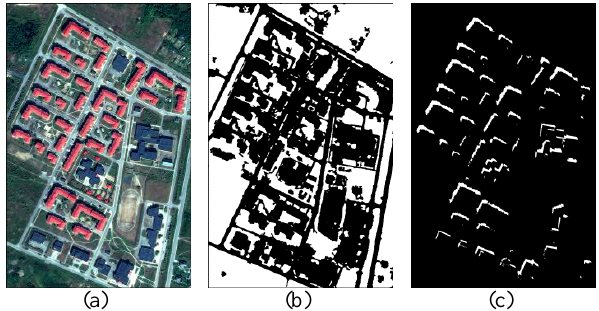
Figure 1. (a) GeoEye-1 pan-sharped image (RGB), (b) vegetation mask ( M V ), (c) post-processed shadow mask ( M PS